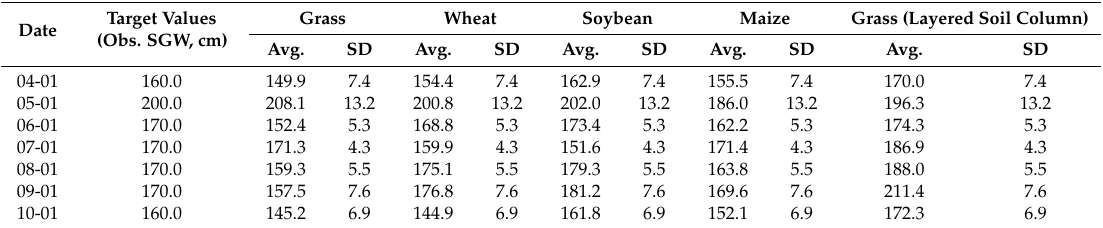
Table 3. Monthly observed (target values) and simulated shallow ground water table depths at ARS 136 site in Oklahoma (1997) with silt loam soil and various vegetation covers under synthetic conditions.